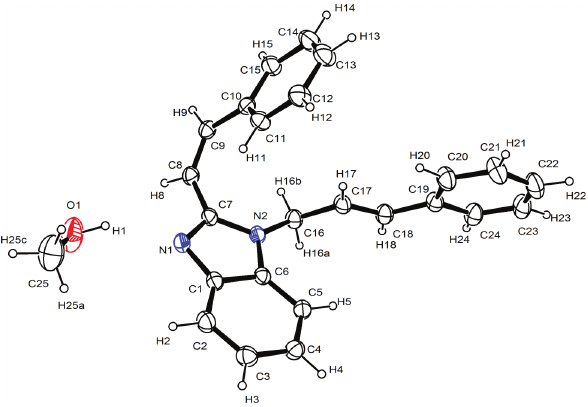
Table 2: Fractional atomic coordinates and isotropic or equivalent isotropic displacement parameters (Å 2